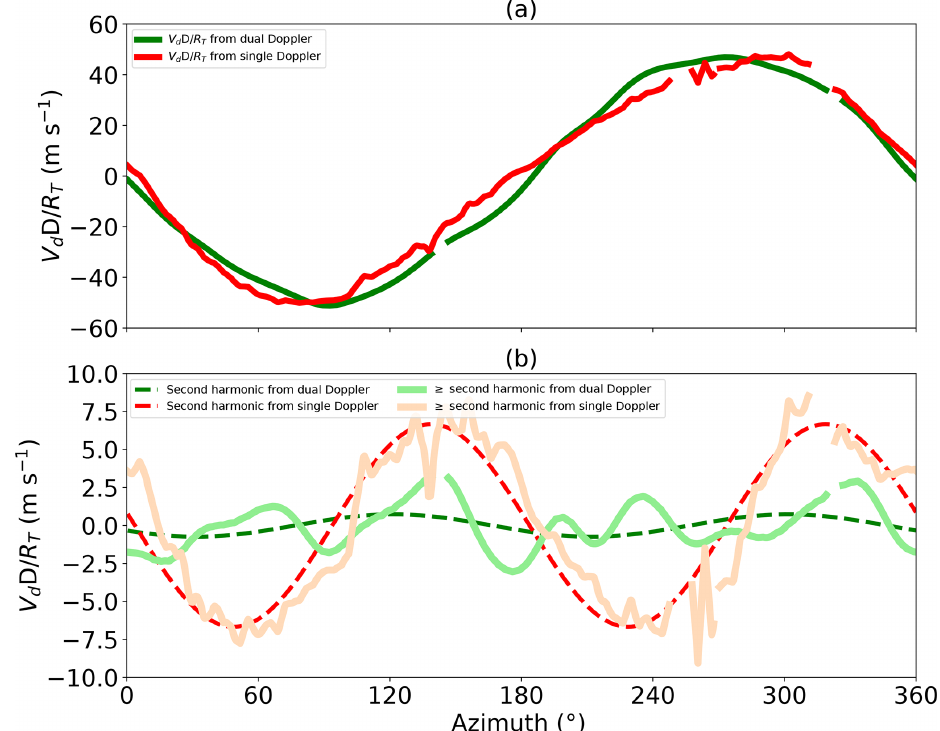
Figure 5. (a) Comparison of retrieved V d D/R T between the dual-Doppler and single-Doppler analyses at the RMW of 18km. The green line denotes retrieved V d D/R T from the resampled dual-Doppler analysis synthesized from 18:55 to 19:40UTC, and the red line denotes retrieved V d D/R T from the KAMX radar at 19:21UTC. (b) Comparison of retrieved second harmonic and higher components of V d D/R T between the dual-Doppler and single-Doppler analyses at the RMW. The solid line denotes the residuals of subtracting the harmonics 0 and 1 from V d D/R T . The dashed line represents the harmonic 2 of V d D/R T .